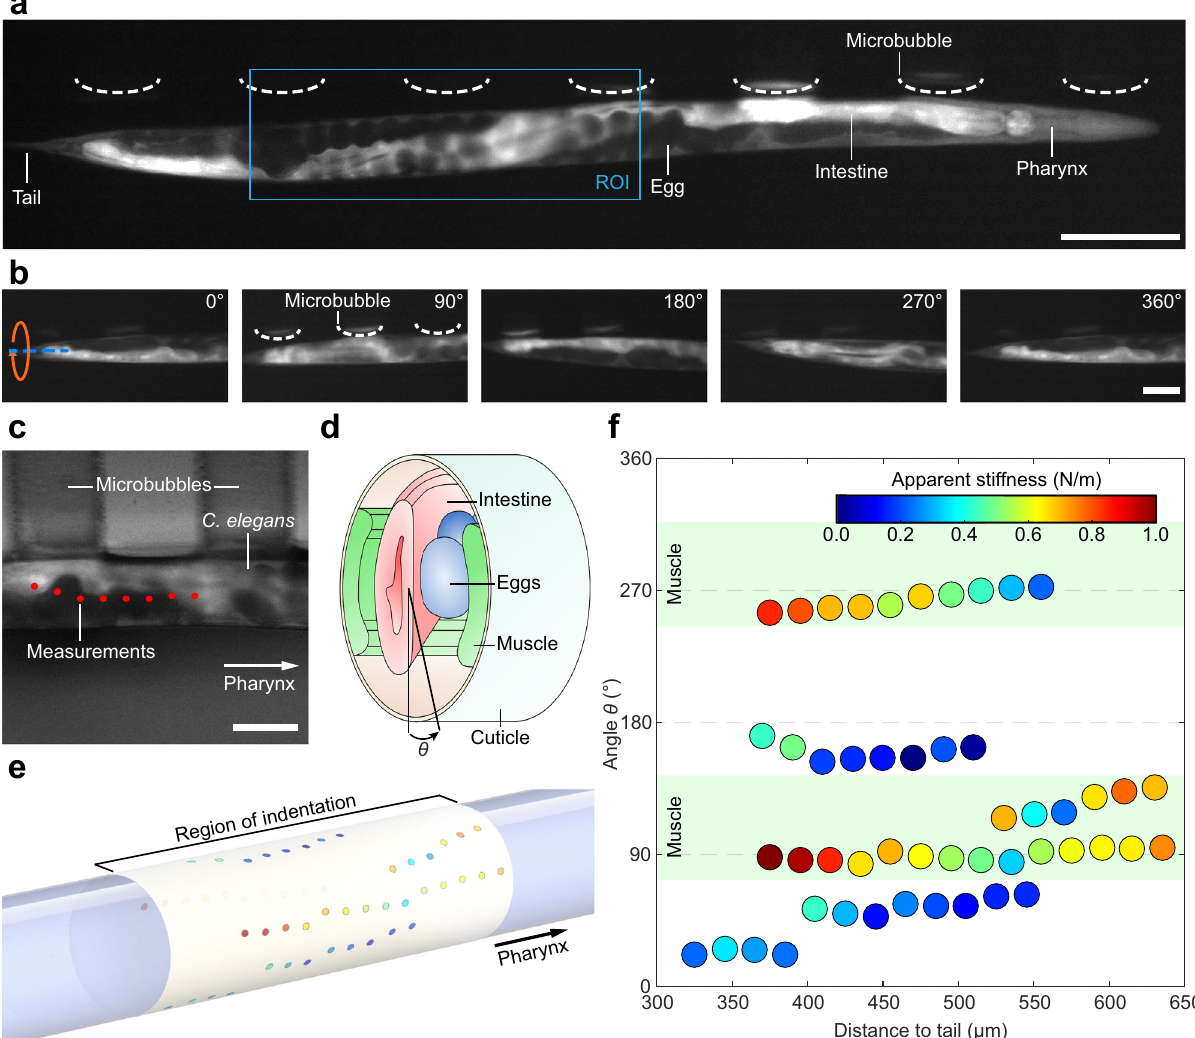
Fig. 3 3D indentation of C. elegans . a A fl uorescence image of a C. elegans nematode trapped in the vicinity of microbubbles using acoustic radiation forces. The region of interest (ROI), where the mechanical characterization was performed, is highlighted in blue. b An image sequence showing different orientations of a C . elegans nematode. The specimen is rotated using acoustic streaming. c A stationary C . elegans worm near the microbubbles. Red dots indicate the individual positions of the micro-indenter probe during mechanical characterization. d Schematic illustrating the composition of internal organs which might lead to different stiffness values measured by micro-indentation and which can be used to extract the right orientation via fl uorescence imaging. The angle θ denotes the location of the indentation in a cylindrical coordinate system. e 3D projection of the stiffness values onto the geometry of a C. elegans nematode showing the different positions around the characterized specimen. f The unfolded stiffness map with individual indentation positions. Multiple bands with different stiffness ranges can be observed. All presented measurements were performed on a single nematode to avoid noise caused by biological variation between specimens. For multicellular organisms, the stiffness does not necessarily quantify a single biological material, but may include the mechanical properties of several overlapping layers and, hence, should be treated as apparent stiffness. Green bands indicate the possible in fl uence of muscular tissue. Scale bars: a = 100 µ m, b = 50 µ m, c = 50 µ m. Source Data is available as a source data fi le for f